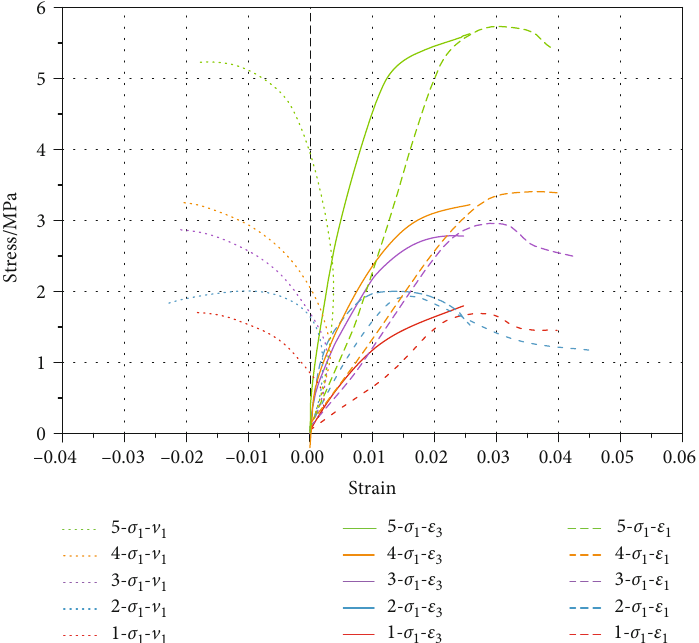
Figure 8: Stress-strain curve of water-bearing coal (8%) under di ff erent con fi ning